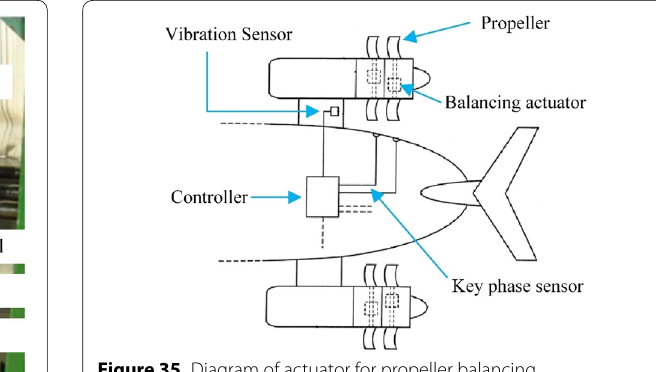
Figure 35 Diagram of actuator for propeller balancing